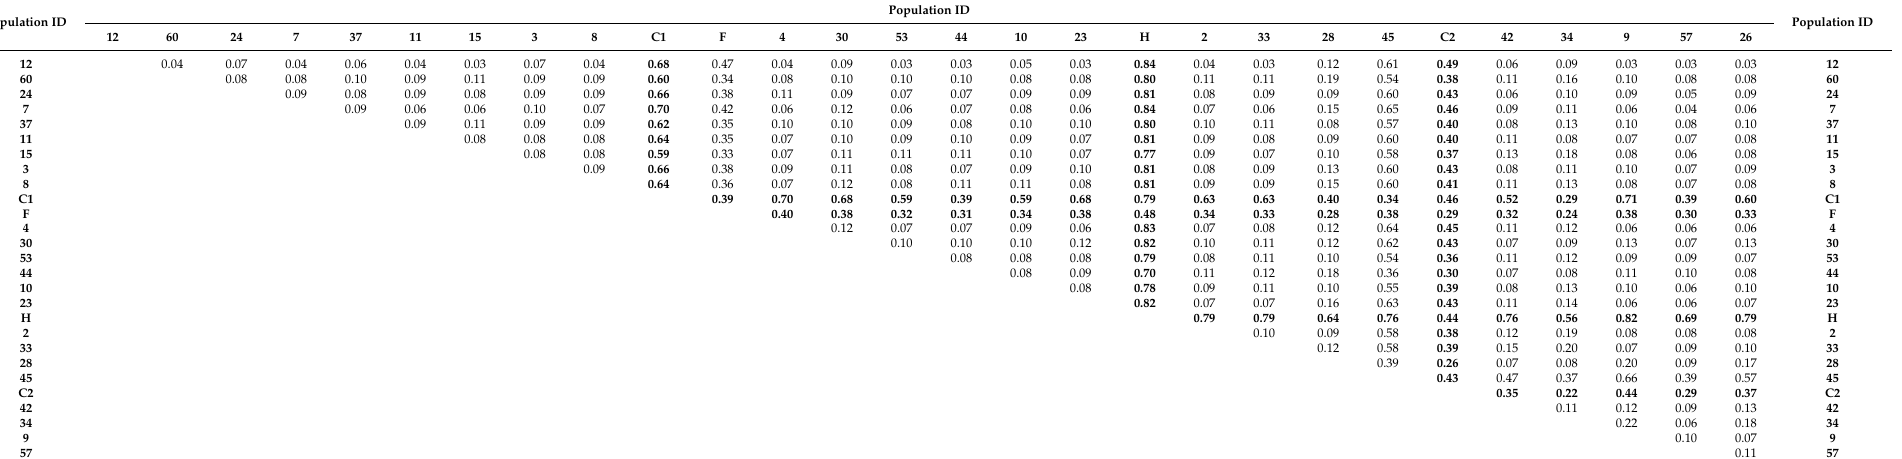
Table 4. The values of fixation index (F st ) calculated according to Weir and Cockerham